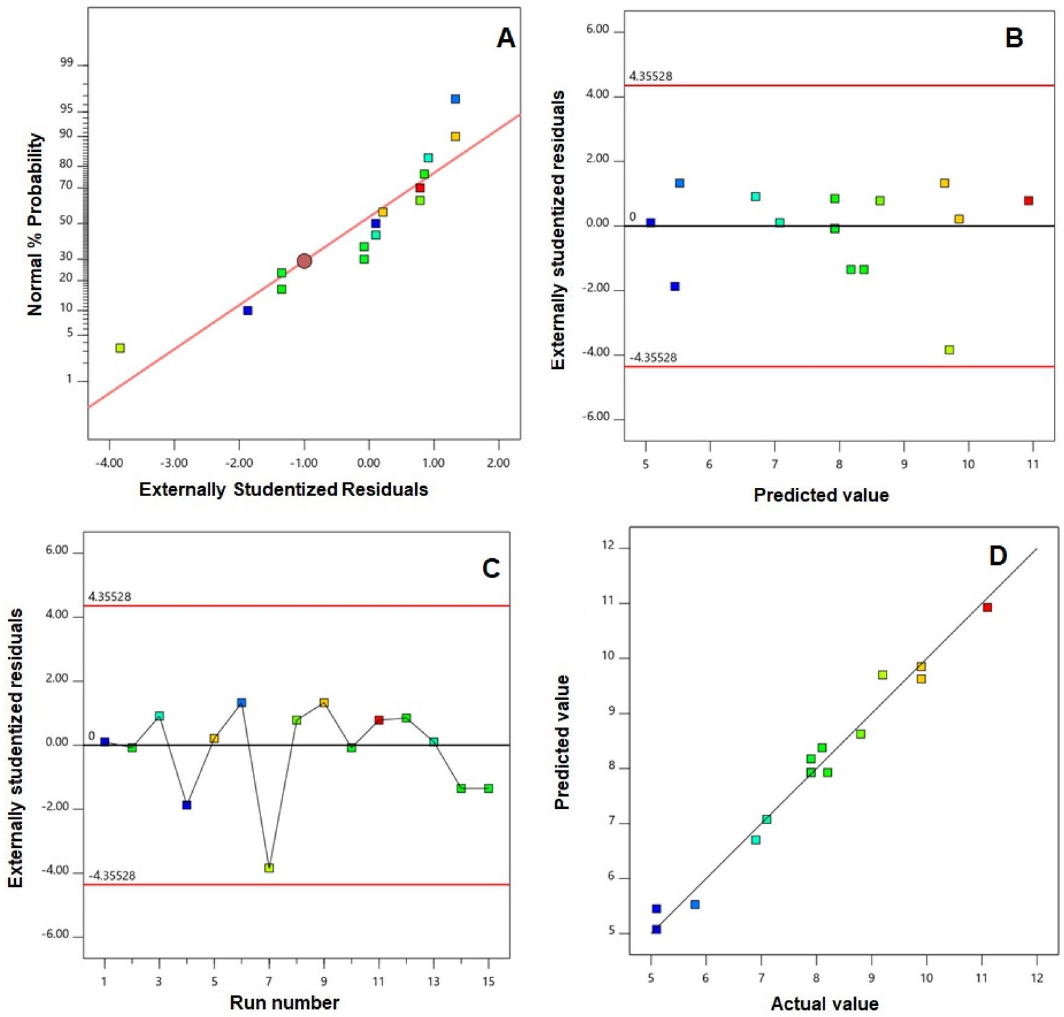
Figure 2. Diagnostic plots for zeta potential of FLV-PL-ALA-MEL nanoparticles. ( A ) Normal probability plot ( B ) studentized residuals vs. predicted values plot ( C ) externally studentized residuals vs. run number plot and ( D ) predicted vs. actual values